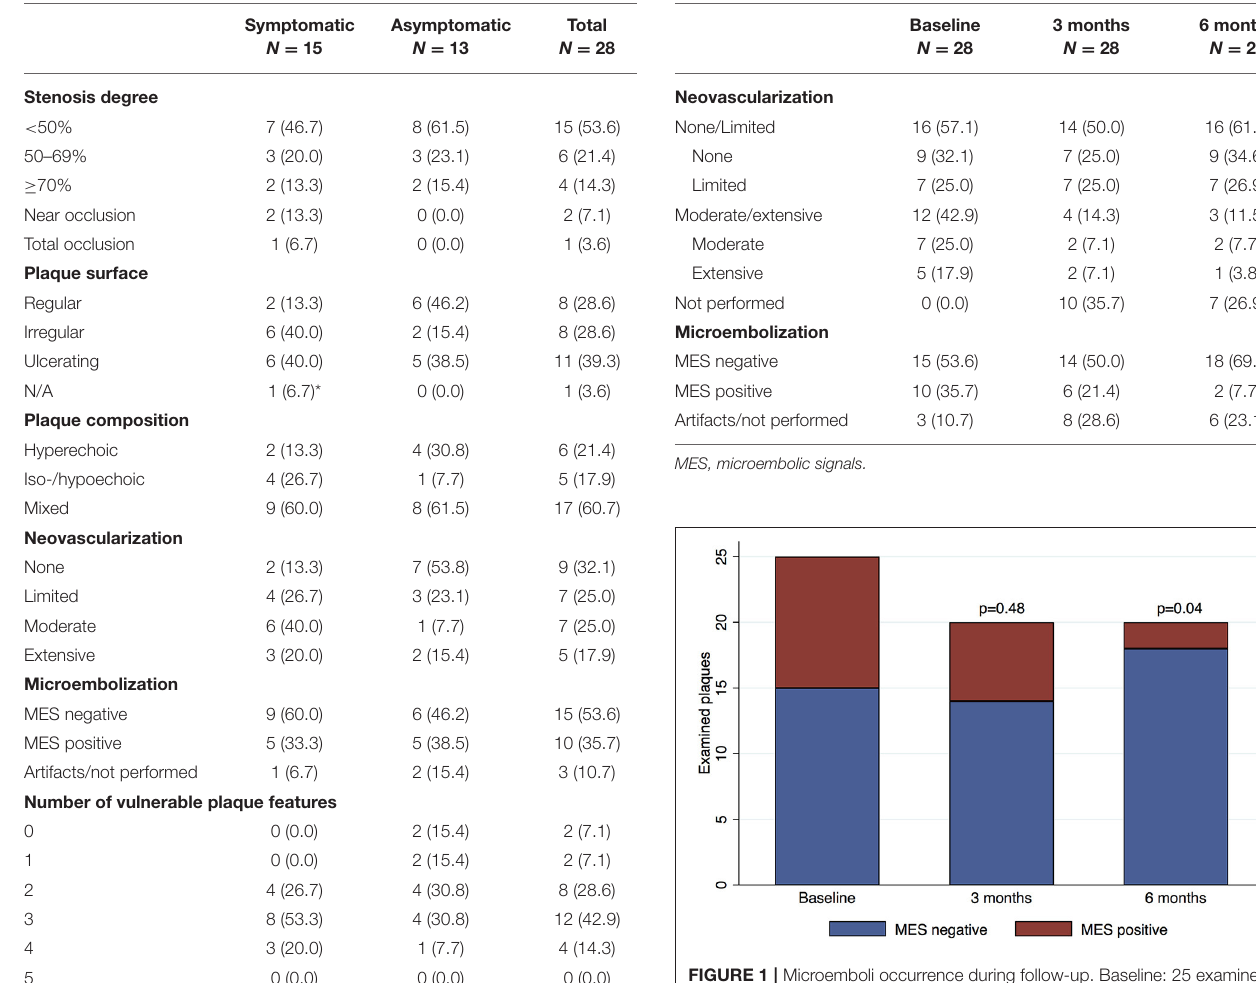
FIGURE 1 | Microemboli occurrence during follow-up. Baseline: 25 examined plaques in 14 patients. Three-month follow-up: 20 plaques in 14 patients. Six-month follow-up: 20 plaques in 13 patients. The surgically removed plaques were excluded from the longitudinal analyses. MES, microembolic